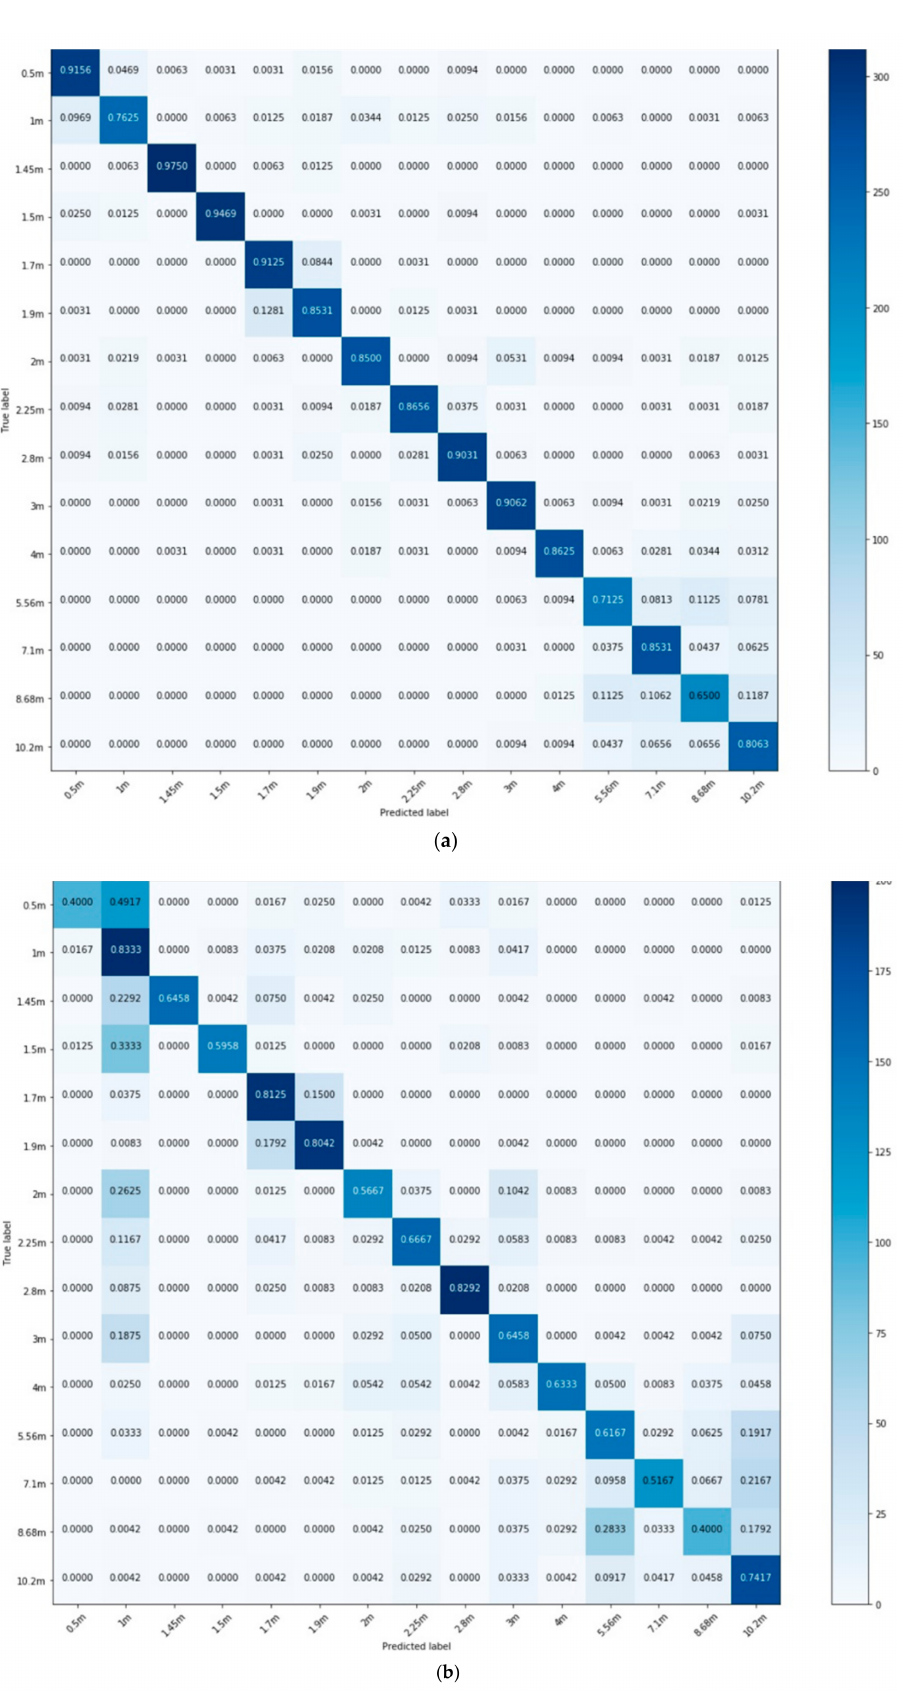
Figure 10. Confusion matrices showing the performances of the model trained on the public dataset. ( a ) Model’s performance on same-speaker test set; ( b ) Model’s performance of di ff erent-speaker test